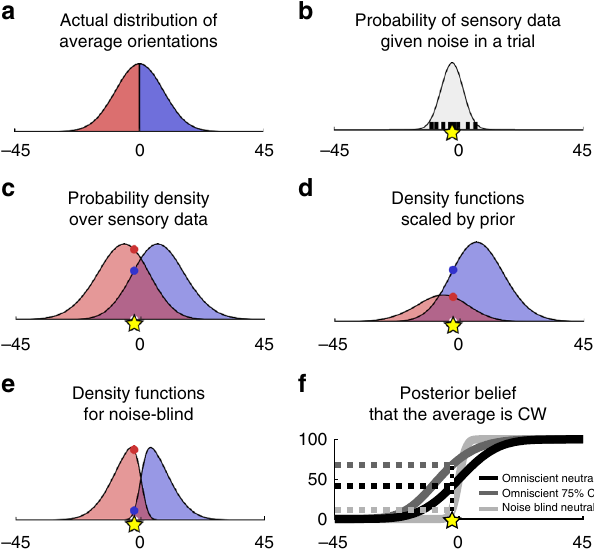
Fig. 4 Computational model. a Distribution of average orientations conditioned on CCW (red) and CW (blue). b An agent ’ s sensory evidence was modelled as a sample from a Gaussian distribution centred on the average orientation of the eight gratings in a stimulus array (black vertical lines), with the variance of this distribution determined by both encoding noise and integration noise. The yellow star marks the sensory evidence for an example trial. c An omniscient agent has a pair of category-conditioned probability density functions over sensory evidence for each experimental condition (i.e. contrast × variability level; here a single condition is shown). The agent uses the relevant pair of density functions to compute the probability of the observed sensory evidence (yellow star) given each category (red and blue dots). Note that, for an omniscient agent, these density functions match the true probability density over sensory evidence under the generative model. See an example of a full set of density functions for an experiment in Supplementary Fig. 1. d Density functions from panel c after scaling by the prior cue (here 75% CW). The sensory evidence (yellow star) is now more likely to have come from a CW stimulus than a CCW stimulus. e The noise-blind model only takes into account encoding noise: the density functions therefore overlap less than in panel c and they do not match the true probability density over sensory evidence. f Posterior belief that the stimulus is CW as a function of the same sensory evidence (yellow star) for the examples shown in panels c (black, omniscient model on neutral trials), d (dark grey, omniscient model when prior cue is 75% CW) and e (light grey, noise-blind model on neutral trials). Steeper curves indicate higher con fi dence; choice accuracy (on neutral trials) is the same for all models. The variability-mixer curve would have intermediate slope between that of the omniscient and the